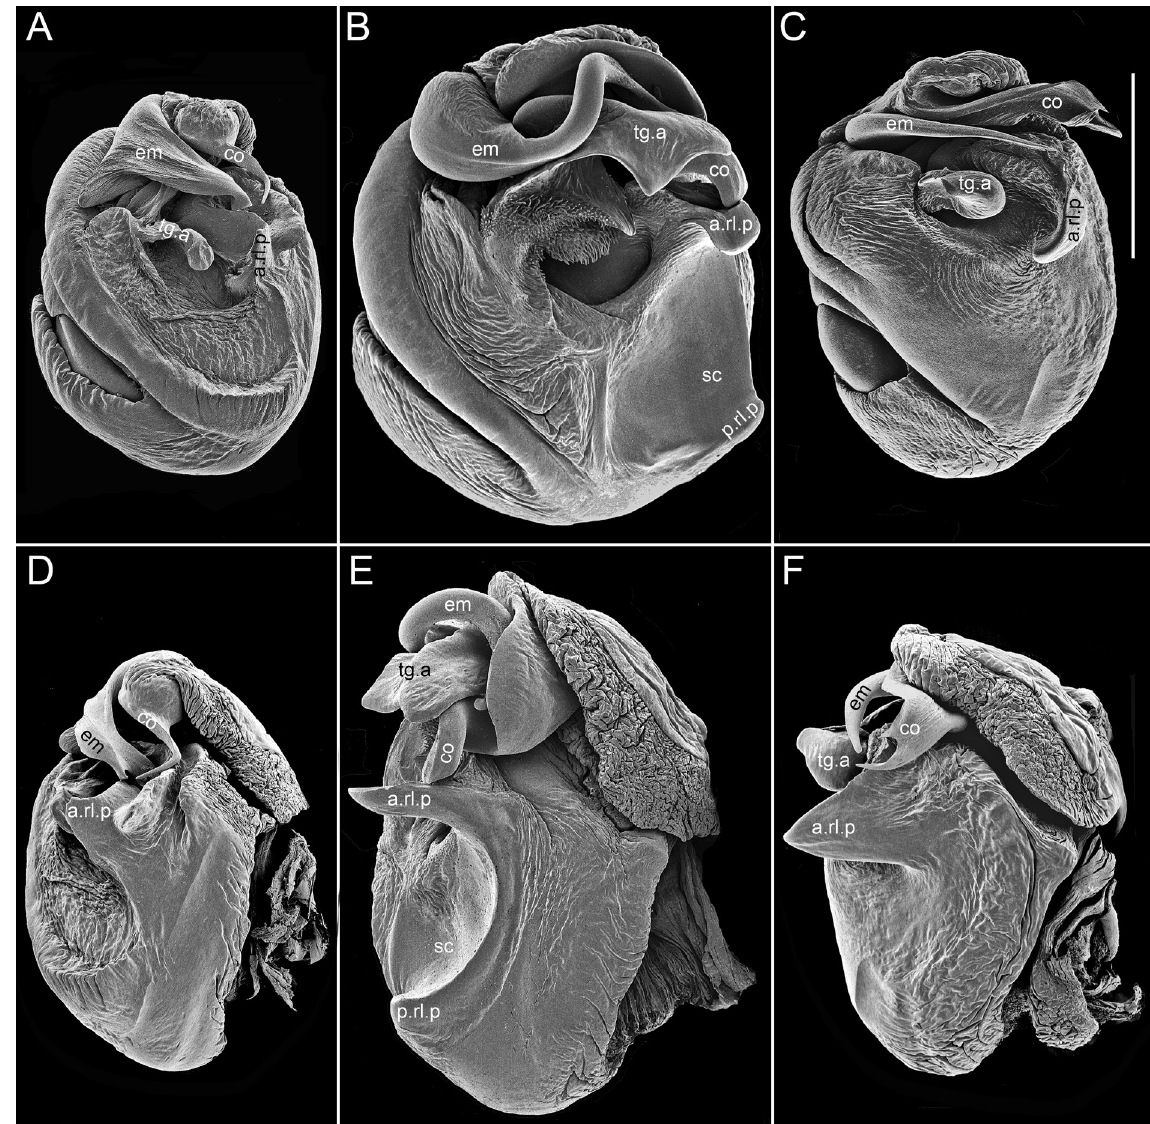
Fig. 4. Bulbus of left male palp in ventral (A–C) and retrolateral (D– F) view. — A, D . Wadicosa benadira (Caporiacco), from Kenya, WNW of Mombasa. — B , E . W. cognata sp. nov., from Kenya, Lake Magadi. — C , F . W. jocquei sp. nov., from Comoros, Moheli. a.rl.p , anterior retrolateral process; co , conductor; em , embolus; p.rl.p , posterior retrolateral process; sc , scutra; tg.a , tegular apophysis. Scale bar: A–F = 300